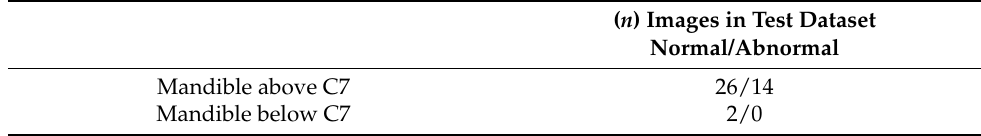
Table 1. The patient position-based test